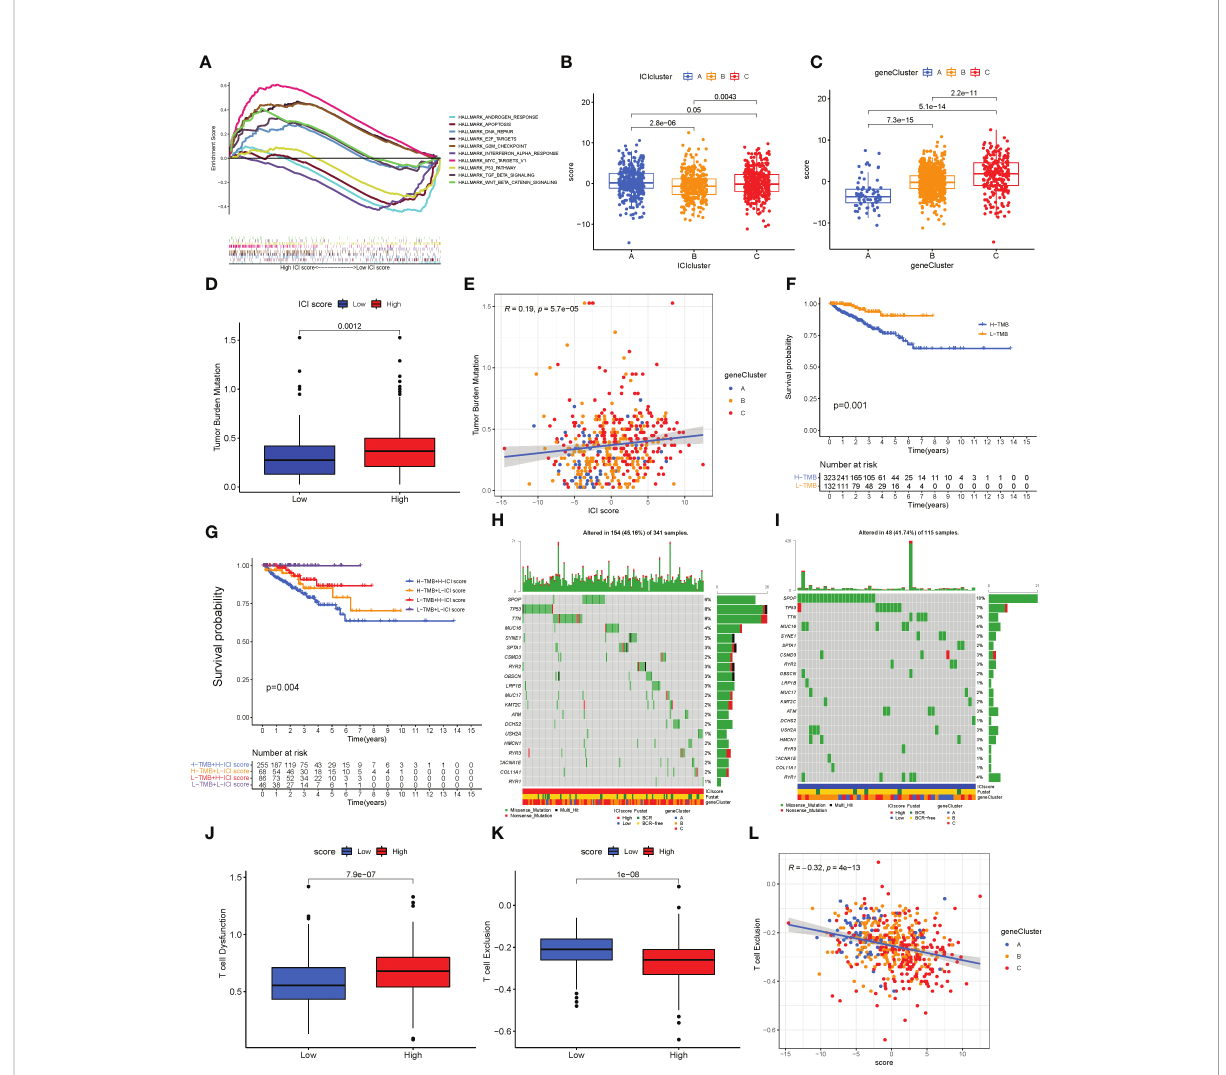
FIGURE 6 Characteristics of the immune cell in fi ltration (ICI) score pattern. (A) Gene set enrichment analysis in patients in the low- and high-ICI-score subgroups. (B, C) ICI score distribution in ICI cluster (B) and gene cluster (C) . (D, E) Patients with high ICI score had a high tumor mutation burden (TMB) value ( D , P = 0.0012), and positive correlation was observed between ICI score and TMB ( E , R = 0.19; P < 0.0001). (F) Kaplan – Meier curve for low and high TMB subgroups in the ICI score cohort (log-rank test, P = 0.001). (G) Kaplan – Meier curve for different subgroups (log-rank test, P = 0.004). (H, I) Top 20 driver genes in patients in the low- (H) and high-ICI-score subgroups (I) . (J) Status of T cell dysfunction in patients in the high- and low-ICI-score subgroups (log-rank test, P< 0.0001). (K, L) Patients with high ICI score had low T cell exclusion ( K ; log-rank test, P< 0.0001), and negative correlation between ICI score and T cell exclusion ( L ; R = 0.21; P <